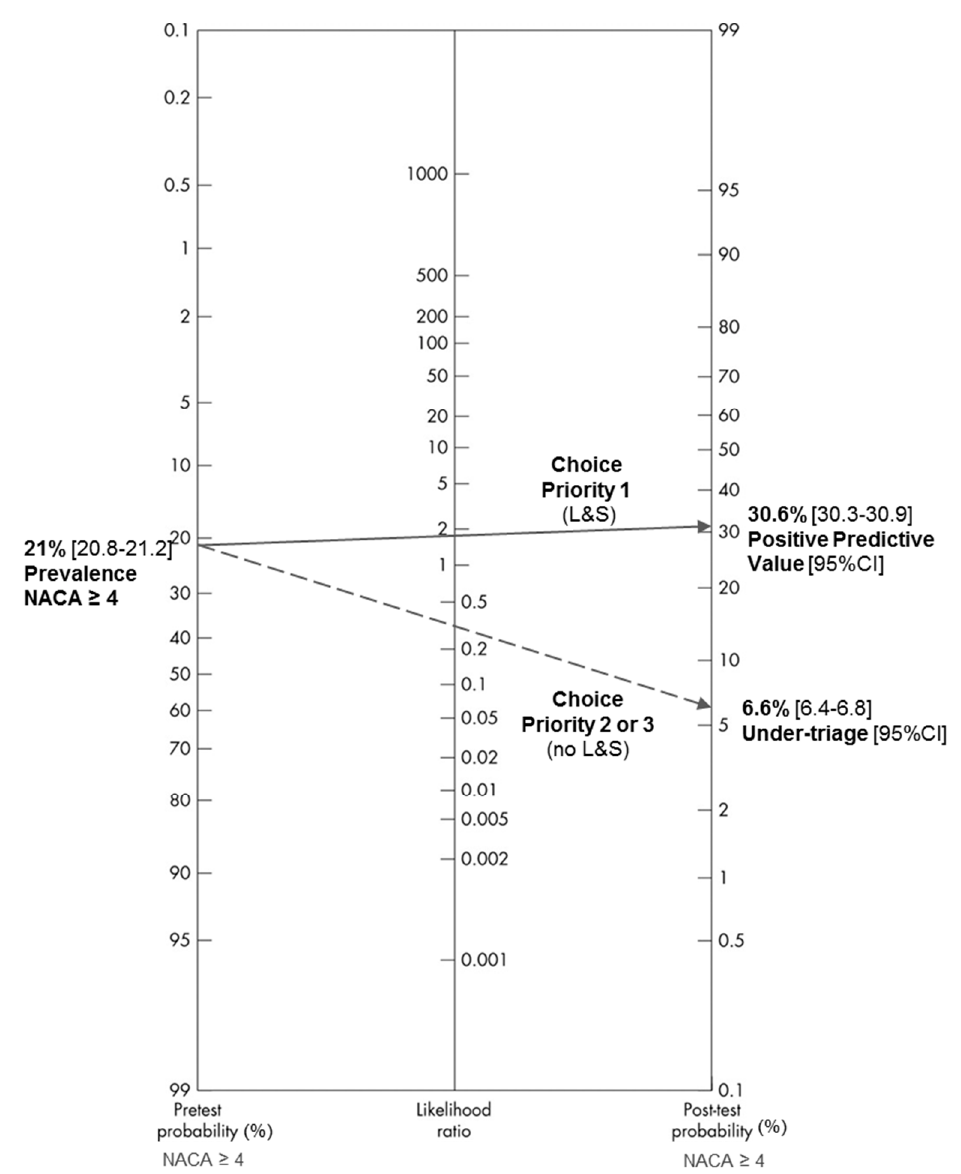
Figure 4. Fagan nomogram of the dispatch with or without L&S in relation to the dichotomized NACA scale (NACA ≥ or < 4).